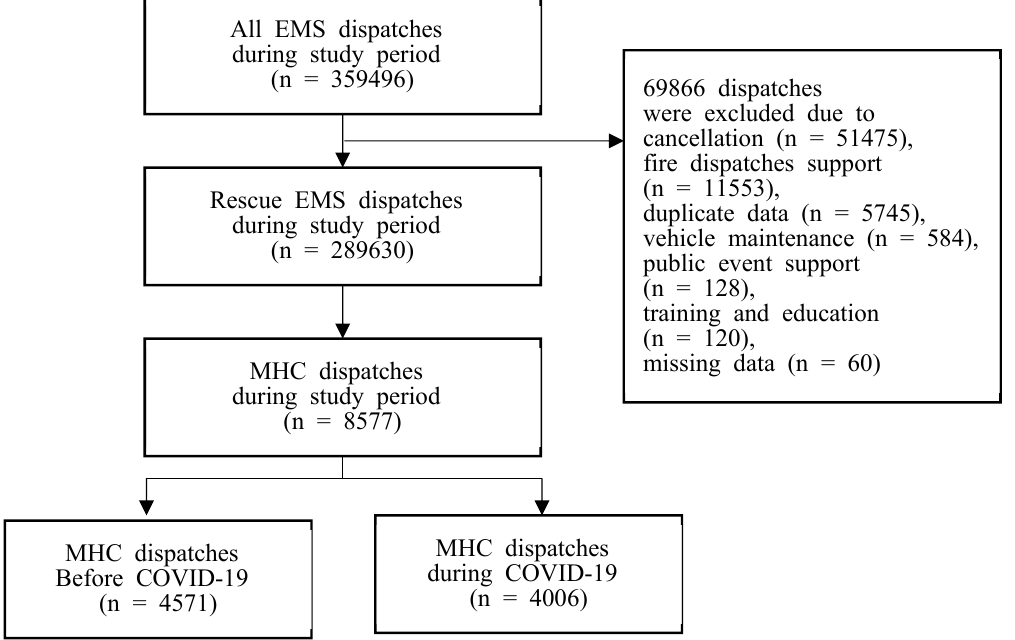
Before COVID-19 (n = 4571) Figure 1. Flow chart of the study population.EMS, emergency medical service; MHC, mental health crisis; COVID ‐ 19, coronavirus disease ‐ 2019.